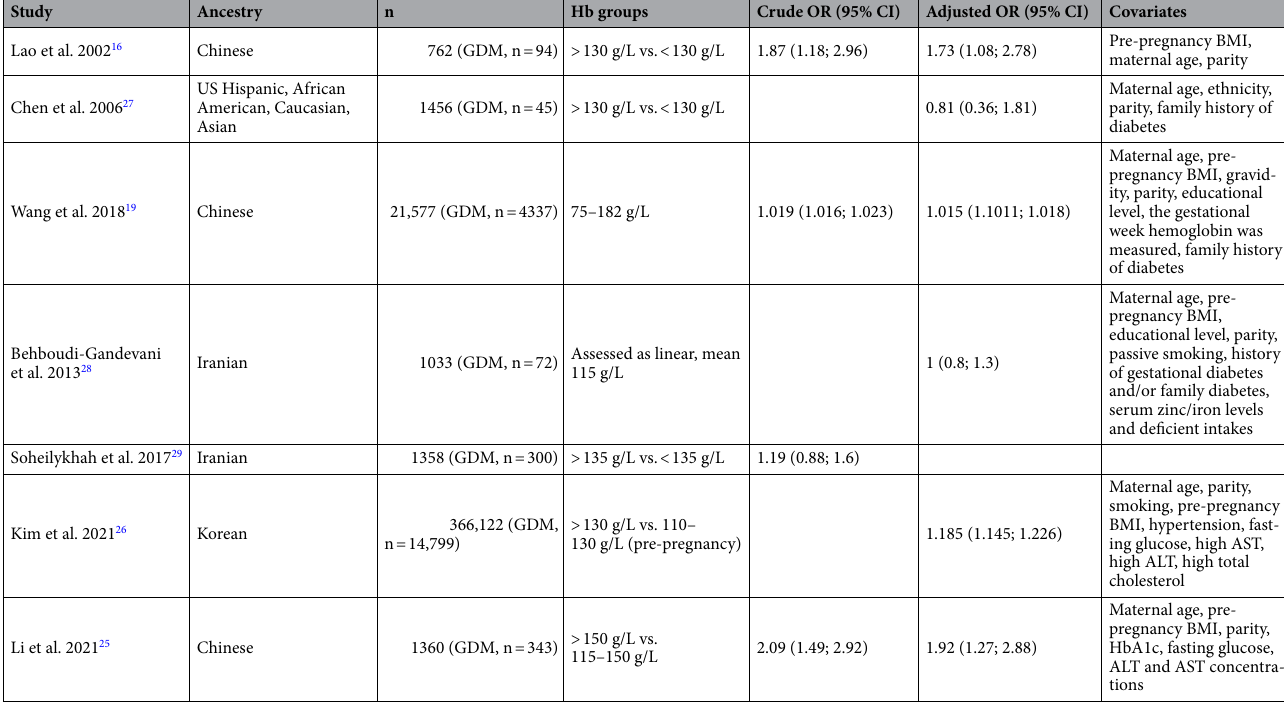
Table 5. Summary of earlier studies presenting data on the association of 1st trimester Hb levels with the risk for GDM. Included were studies reporting odds ratio (OR) with 95% confidence intervals (CI).